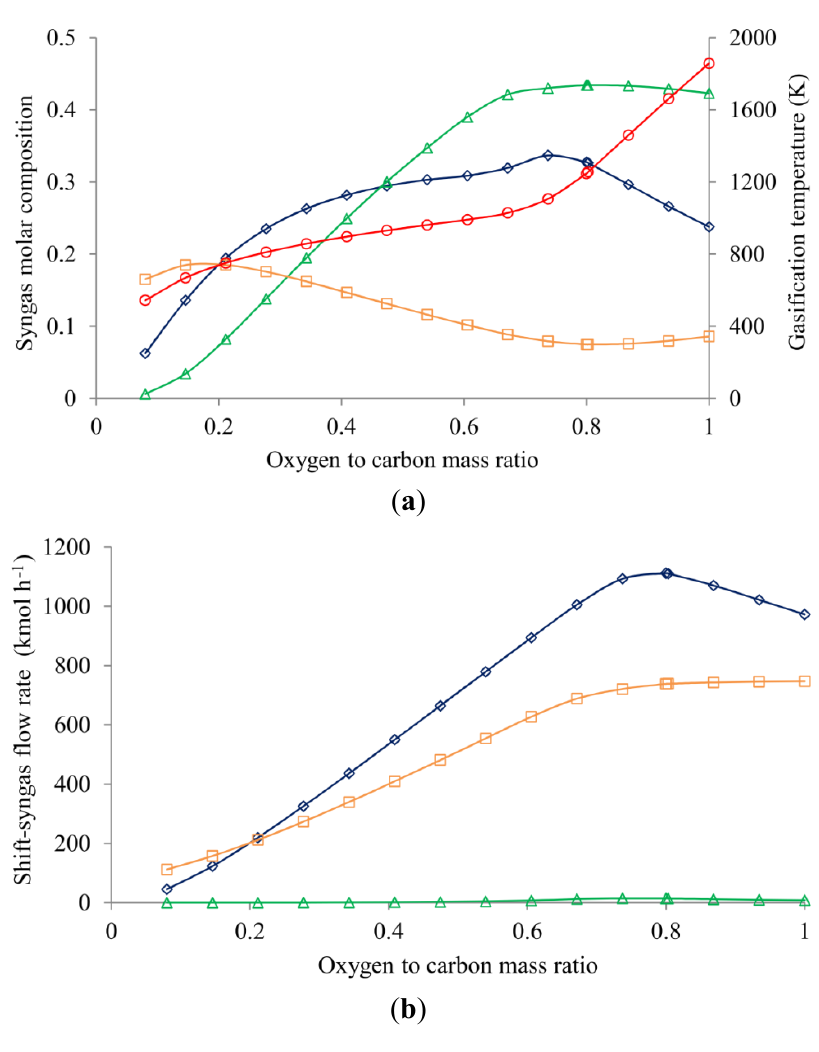
Figure 1. Effect of the O to carbon ratio on ( a ) the syngas molar composition upstream 2 WGS reactors and ( b ) molar flow rate downstream WGS reactors: CO ( ∆ ), H and adiabatic temperature ( ○ ) with solid concentration in coal slurry: 0.65, WGS process SDG: 0.59, LTS reactor operating temperature: 473 K and HTS reactor operating temperature: 623 K as fixed